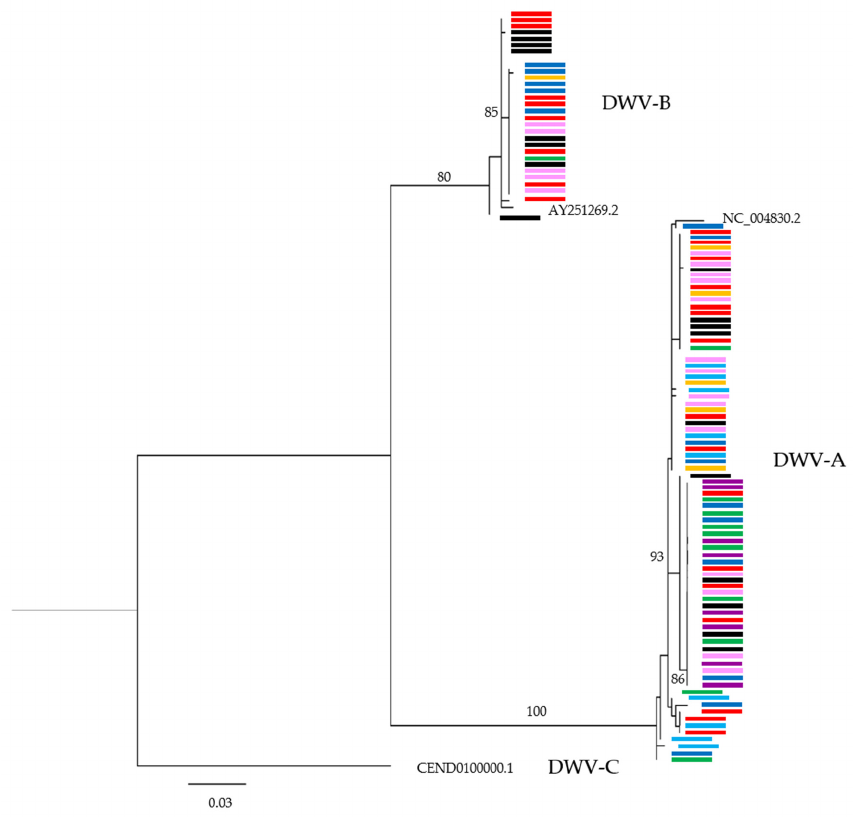
Figure 5. Maximum likelihood phylogeny of a 507 bp RdRp fragment of the DWV genome. Coloured bars donate sequences obtained from each taxon group. Sequences from honey bee samples are shown in black, solitary bees in red, solitary wasps in magenta, yellowjacket wasps in blue, potter wasps in orange, paper wasps in green, ants in light blue and flies in pale pink. Bootstrap support values of >80% are shown.